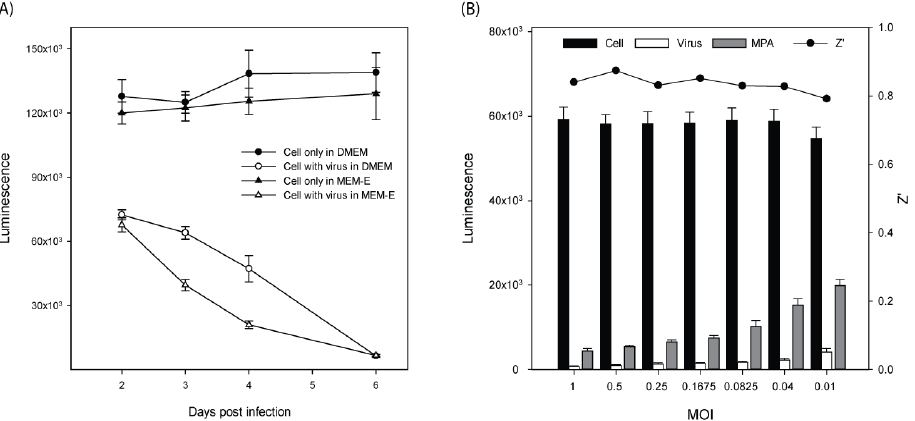
Figure 1. Assay optimization for assay media, incubation period, and MOI. (A) Vero E6 cells were infected with WNV at 0.05 MOI using the 96-well plate format and developed on successive days. Virus cultured in MEM-E produced a higher CPE between day 3 and day 5 than in DMEM. (B) Assay robustness with Z´ factor and inhibition profiles using MPA (positive control) and different amounts of virus in a 384-well plate format. Z´ factor was higher than 0.75 in a 0.01~1 MOI range. The inhibitory activity of MPA was greater at the lower